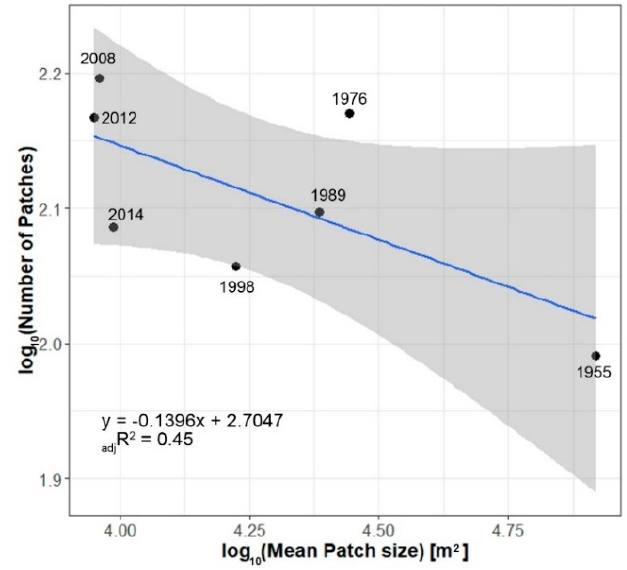
Figure 7. The agricultural terraced patch dynamics of the study area from 1955 to 2014.